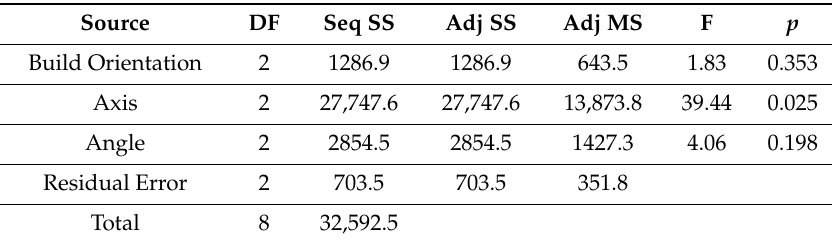
Table 5. ANOVA for E obtained through Taguchi analysis.